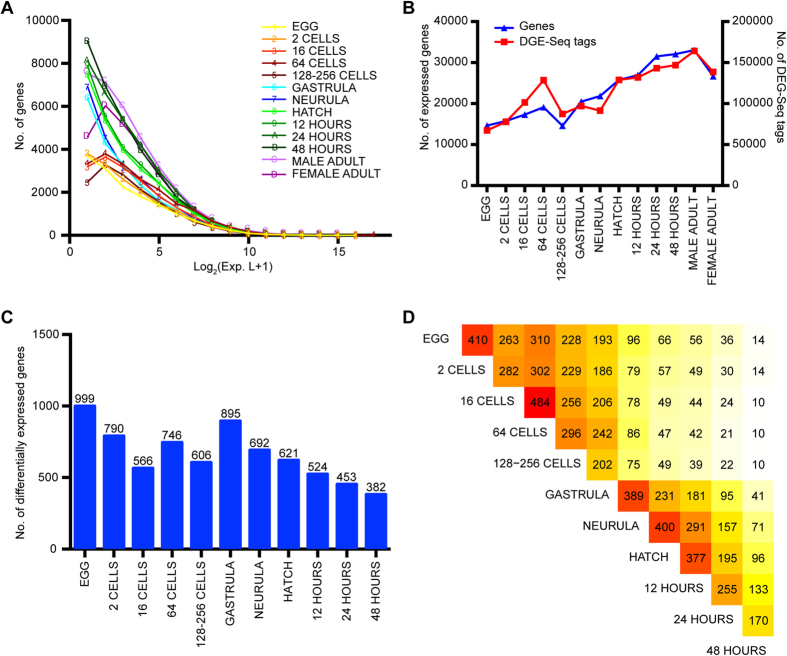
Expression profiles of transcripts across different developmental stages in amphioxus.(A) Distribution of expression levels (Exp. L.) across 13 developmental stages. The transformed expression values of transcripts at each stage were binned with interval size 1, and the number of genes falling within each bin was calculated. (B) Number of expressed genes and DEG-Seq tags in each developmental stage. Expressed genes were defined as those with log2(Exp. L.+1) > 0. (C) Number of differentially expressed transcripts at each developmental stage. Transcripts that were highly expressed in non-adult stages but down-regulated in the adult stage were calculated, with FDR ≤ 0.01. (D) Overlap of differentially expressed transcripts in each pair of developmental stages. The number of overlapped transcripts is represented by the colours.